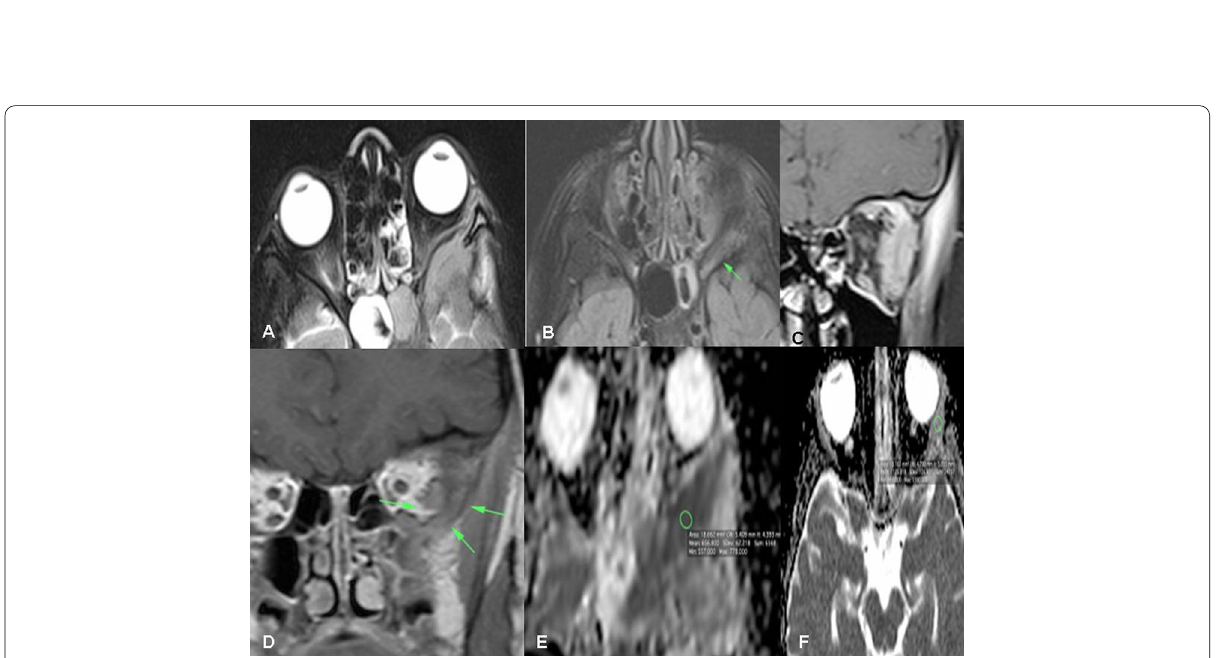
Fig. 11 A 14-year-old male patient with history of rapid left-sided proptosis, swelling in the lateral aspect of the left orbit and dull aching left orbital pain. Initial orbital MRI with contrast was done. Axial T2-weighted image A shows hypointense infiltrative mass involving the left extraconal fat, the lateral bony wall, the left sphenoid bone and sinus, with left temporal epidural component. Axial FLAIR follow-up image B shows isointense signal with reduction in mass size and loss of its epidural component as compared to the initial MRI study. Coronal post-contrast T1-weighted image C shows an enhancing left lateral extraconal mass in the left orbit Follow-up coronal post- contrast T1-image D shows marked reduction in the mass size and enhancement. Evident diffusion restriction on DWI (b 1000 )/ADC ( E , F ). The ADC value of 1.12 10 − 3 mm 2 /s. Pathologically proved left orbital × extraconal infiltrative